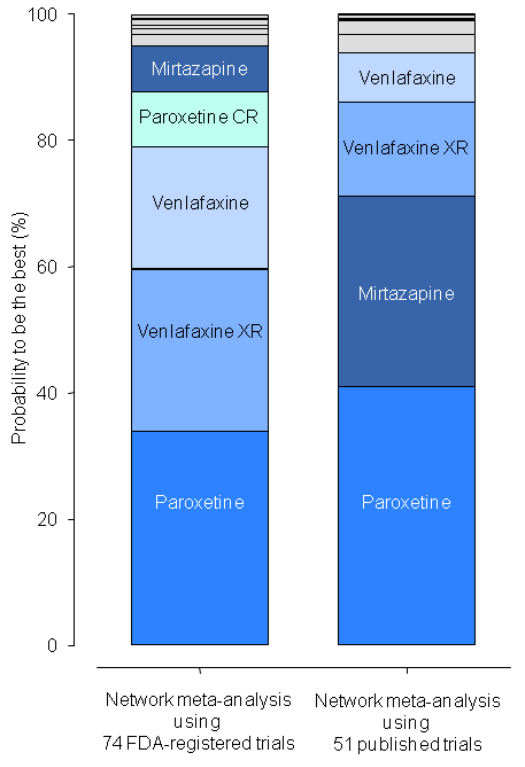
Figure 3. Probabilities that each antidepressant drug is the best according to network meta-analyses of data from 74 FDA- registered trials or 51 published trials with published effect sizes. For instance, for mirtazapine, the probability of being the best was 7.3% and 30.2% according to network-meta-analysis of the 74 FDA- registered trials and 51 published trials with published effect sizes, respectively. Drugs for which the probability of being the best was , 5% for both published and FDA data are not labeled (blue area).